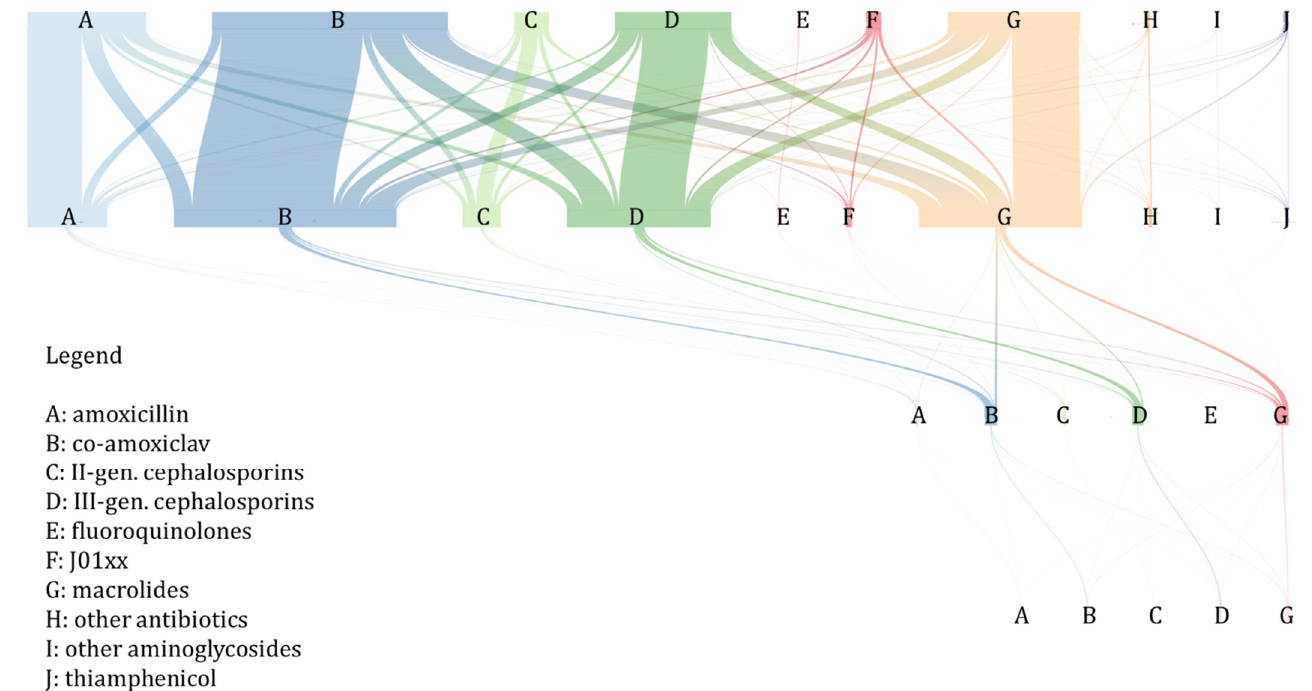
Figure 6. River plot of antibiotic treatment switching and prolongation. The rows of letters represent the prescriptions grouped by antibiotic classes in timely order from the upper part (first prescription) to the bottom part (last prescription), and the coloured lines show the connection with the following prescriptions in the same treatment episode (Pedianet, 2012–2018).